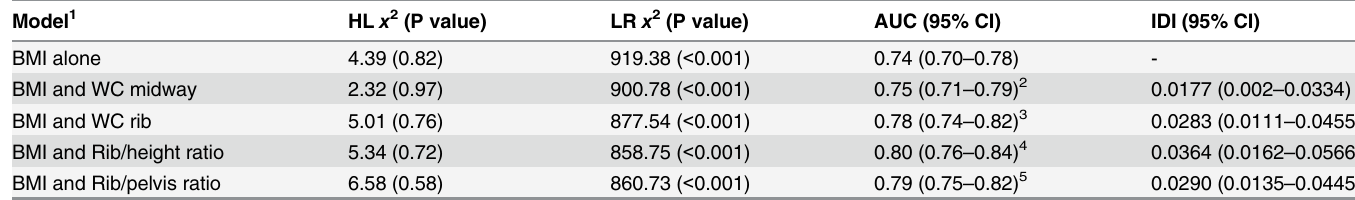
Table 3. Tests of calibration, goodness-of-fit and discrimination for prediction models to identify subjects with type 2 diabetes.